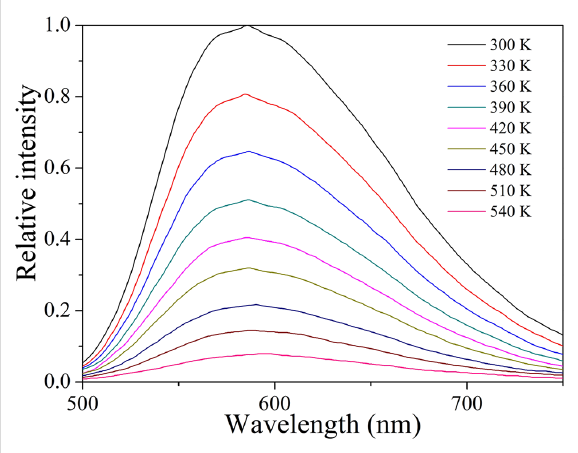
Figure 5: Emission spectra of Tb 2.81 Ce 0.04 Gd 0.15 Al 5 O 12 at different temperatures.